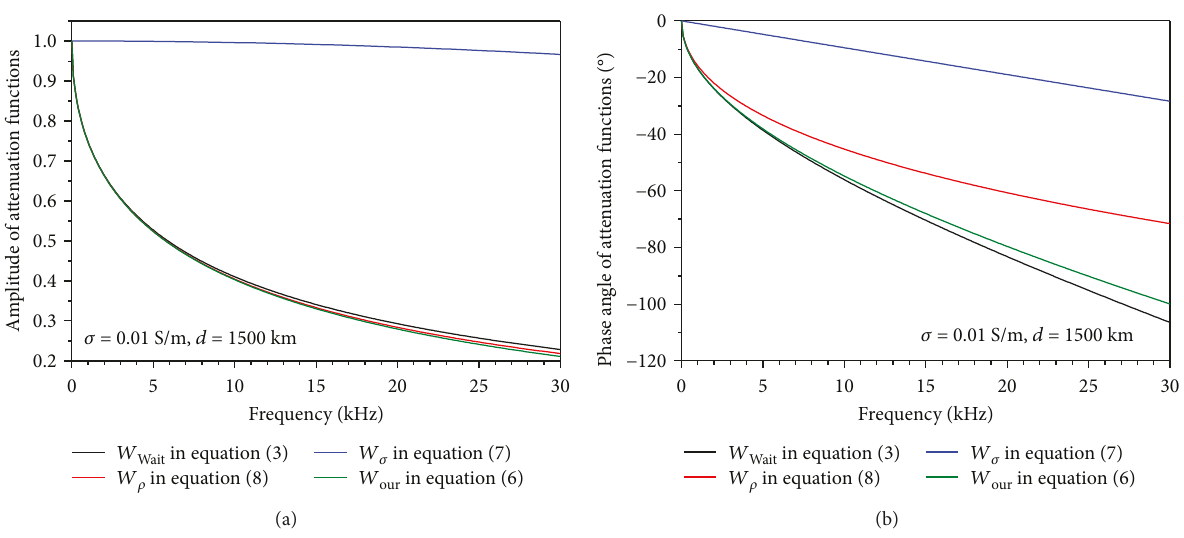
Wait is the attenuation function